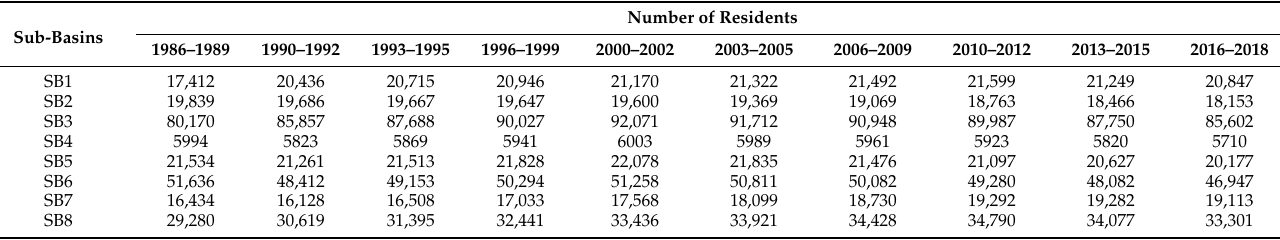
Table 2. Number of residents in each sub-basin in Low Mondego.